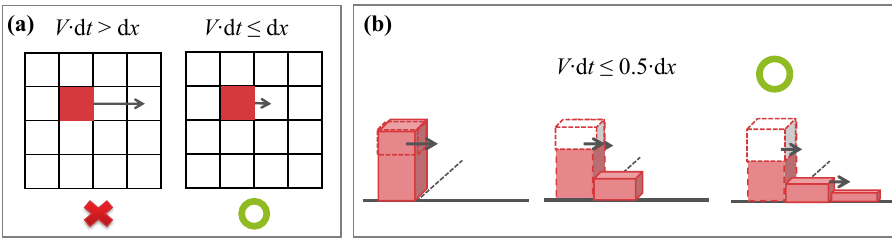
Figure 5. Illustration of stability conditions for calculation of water and sediment